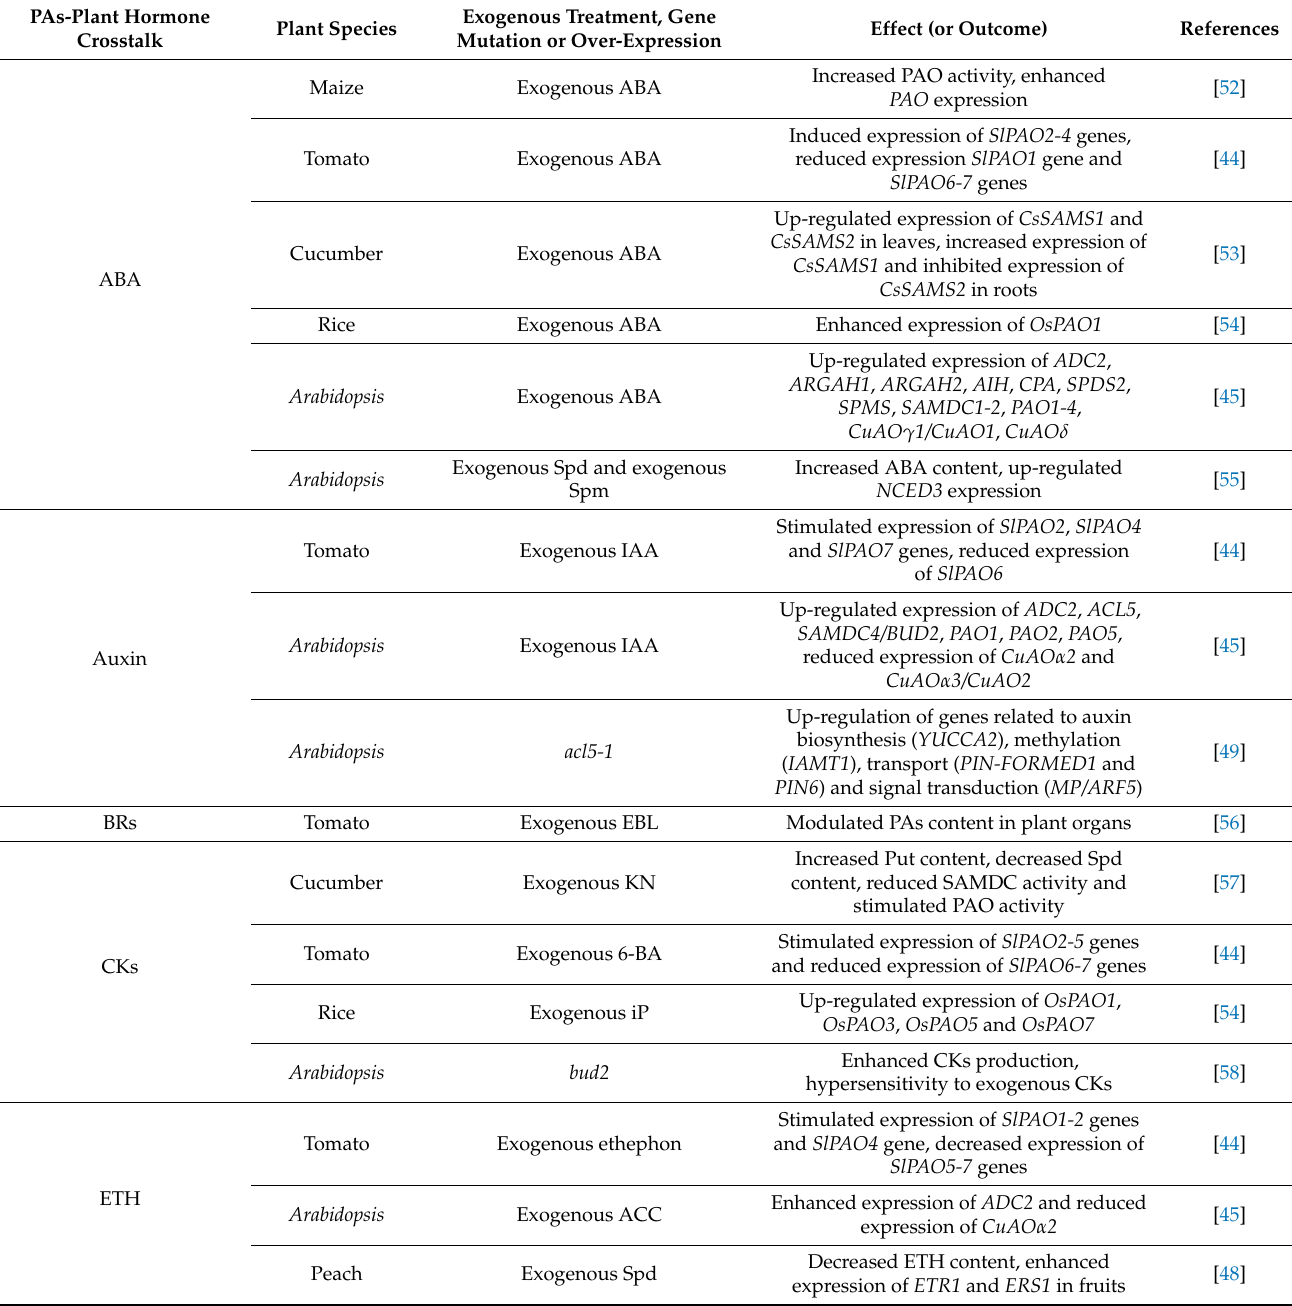
Table 1. Representative evidence for the interaction between PAs and plant hormones during plant growth and development. 6-BA, 6-benzylaminopurine; IAA, indole acetic acid; iP, isopentenyl adenine; NaSA, sodium